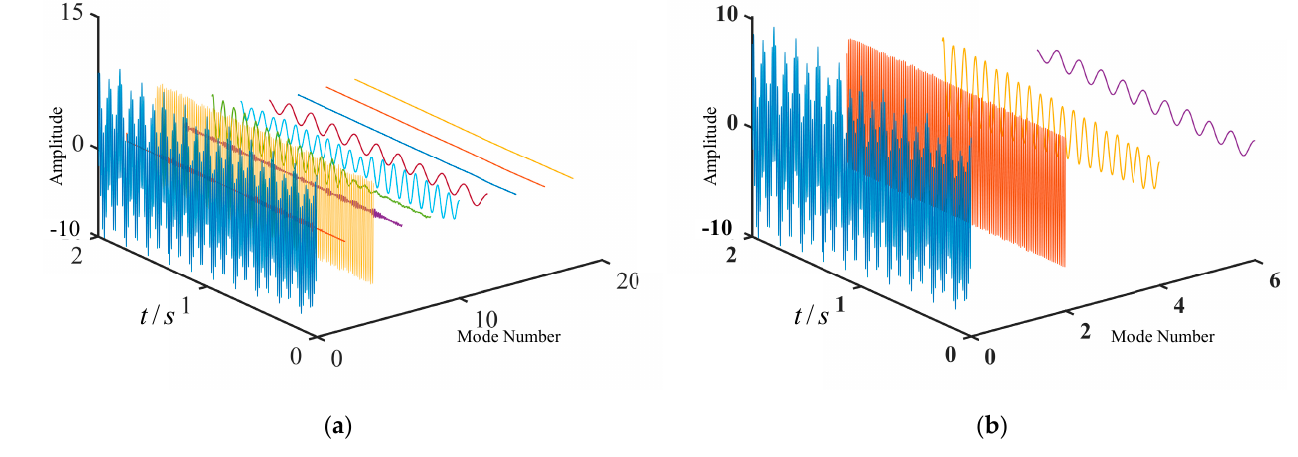
Figure 5. The decomposition results: ( a ) ICEEMDAN; ( b ) MICEEMDAN.